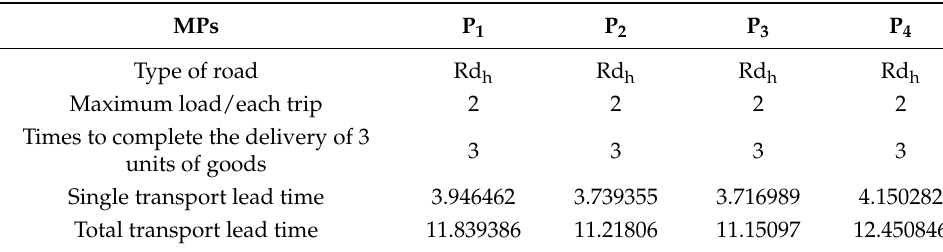
Table 5. Transport lead time on Rd h